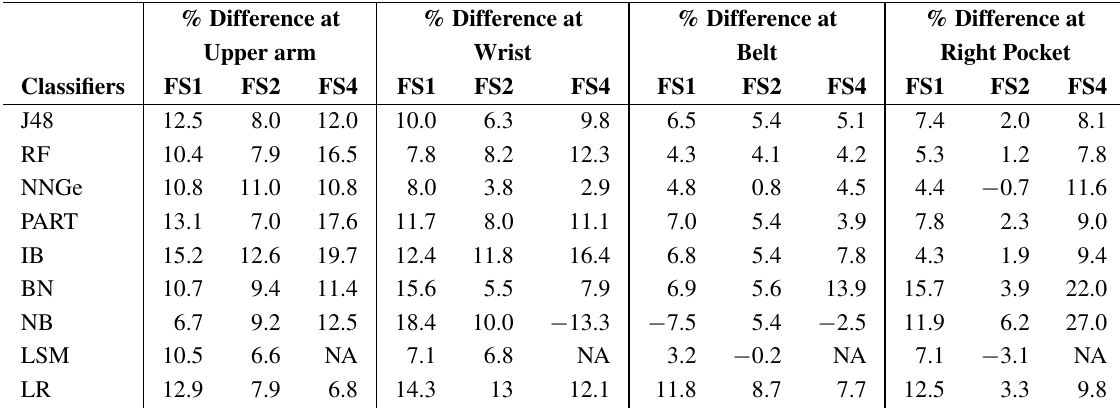
Table A.6. Performance difference (AG − max(A,G)) for the walking upstairs activity in Scenario